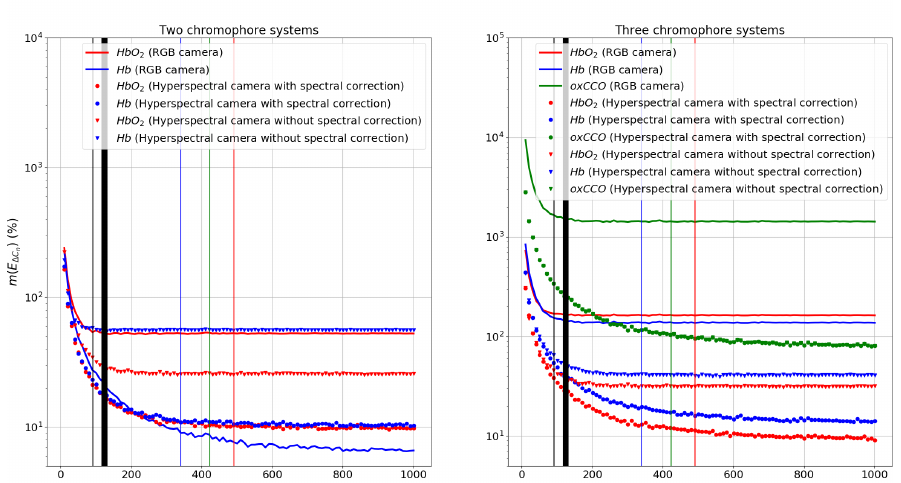
Figure 8. Mean quantification errors in ∆ C HbO (b), ∆ C Hb (blue curves), and ∆ C oxCCO (green curves) 2 (see Equation (10)) obtained for the optimal spectral configuration of the hyperspectral camera (see Figure 7) and the RGB camera as a function of SNR. The solid lines were computed using the RGB camera; the curves with circles and with triangles were computed using the hyperspectral camera with and without spectral correction, respectively. Red, green, and blue vertical lines indicate the SNR values of the R, G, and B channels of the RGB camera and black vertical lines the SNR values of the spectral channels of the hyperspectral camera.